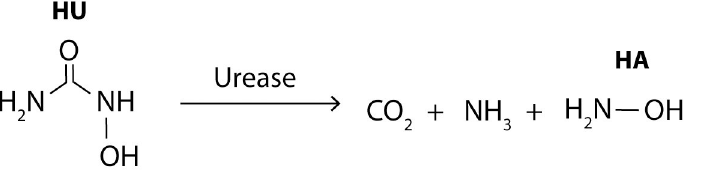
Fig 5. Urease mediated HU metabolism